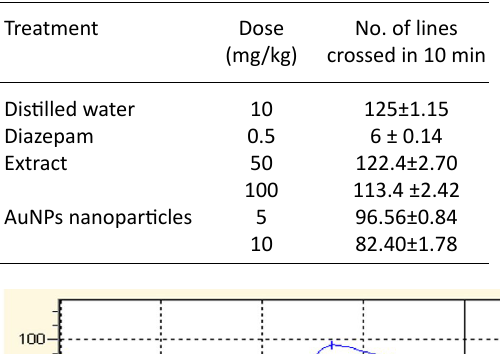
Table 5. Analgesic activity of Trachyspermum ammi extract and AuNPs